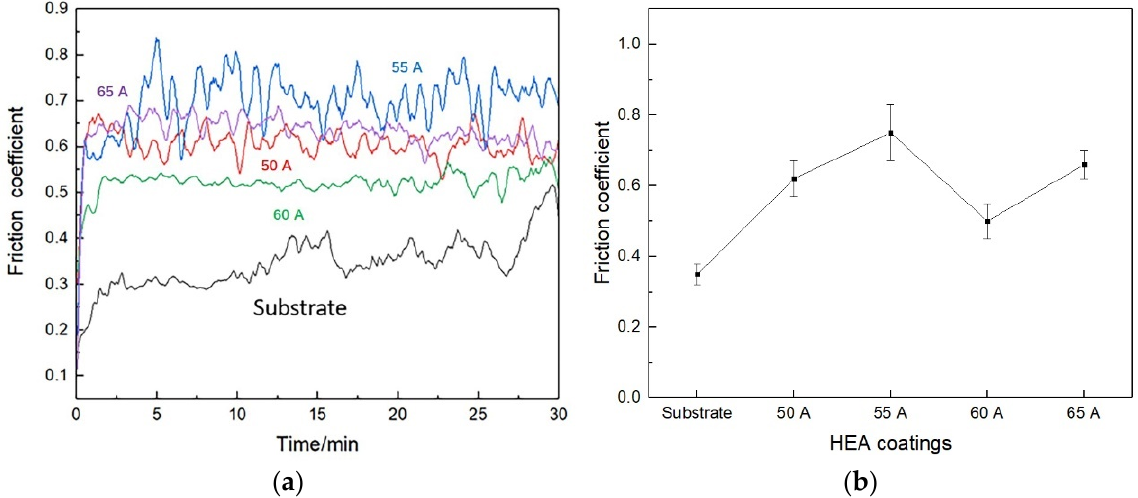
Figure 8. ( a ) Friction coefficient of the CoCrFeNiMn HEA coating and CGI substrate, ( b ) the average friction coefficient of the CoCrFeNiMn HEA coating and CGI substrate.